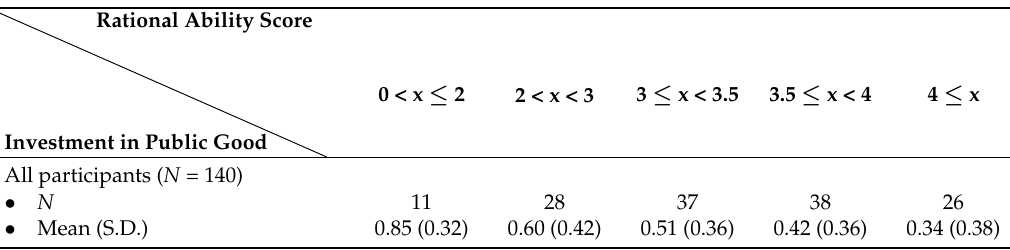
Table 2. Investment in public good by participants with different rational ability